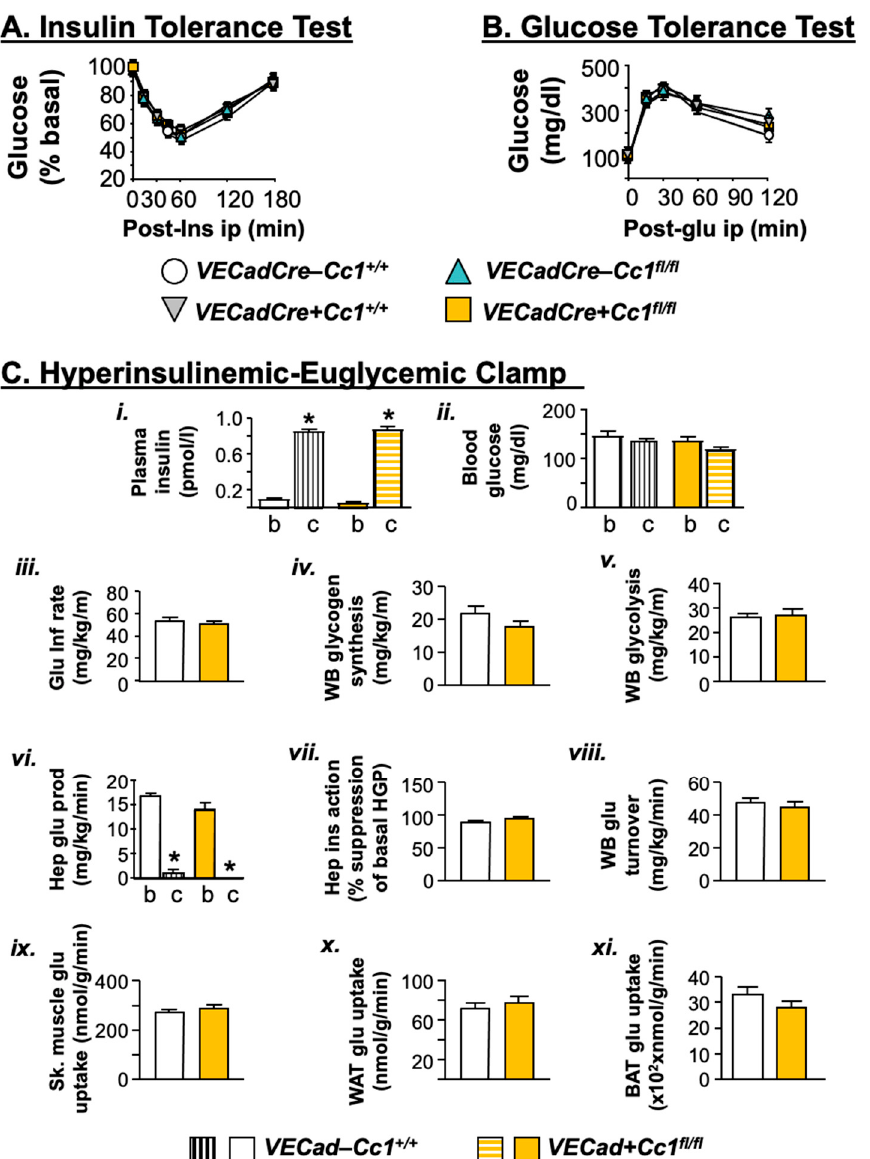
Figure 3. Metabolic phenotyping. Twelve-month-old male mice ( n ≥ 7–8/genotype/age group) were injected intraperitoneally with insulin or glucose to assess insulin ( A ) and glucose tolerance ( B ). Values were expressed as mean ± SEM; VECad − Cc1 +/+ (wild-type controls), VECad+Cc1 +/+ (Cre controls), VECad − Cc1 fl/fl (Flox controls) and VECad+Cc1 fl/fl (null mice). ( C ) Hyperinsulinemic- euglycemic clamp analysis performed on 7-month-old awake overnight-fasted VECad − Cc1 +/+ and VECad+Cc1 fl/fl nulls. n ≥ 8/genotype. Values are expressed as mean ± SEM. * p < 0.05 clamp (c) vs basal (b). Glu Inf rate denotes glucose infusion rate, WB denotes whole body, Hep denotes hepatic, WAT denotes white adipose tissue, and BAT denotes brown adipose tissue. At the cellular level, Western blot analysis revealed that insulin induced IR beta (IR β ) phosphorylation to the same extent in mutant and wild-type LEC, as indicated by im- munoblotting cell lysates with antibodies against phosphorylated IR β ( α -pIR β ) antibody normalized to IR β (Figure 4A). Like IR β , insulin receptor alpha (IR α ) protein level was intact in LEC from null mice (Figure 1B( ii )).